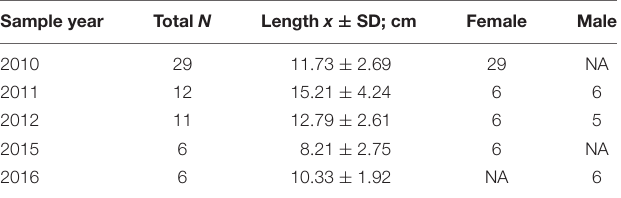
TABLE 1 | Total number of Peruvian fur seal Arctocephalus australis unnamed sp. vibrissae analyzed in this study, including year sampled, mean vibrissae length, and associated